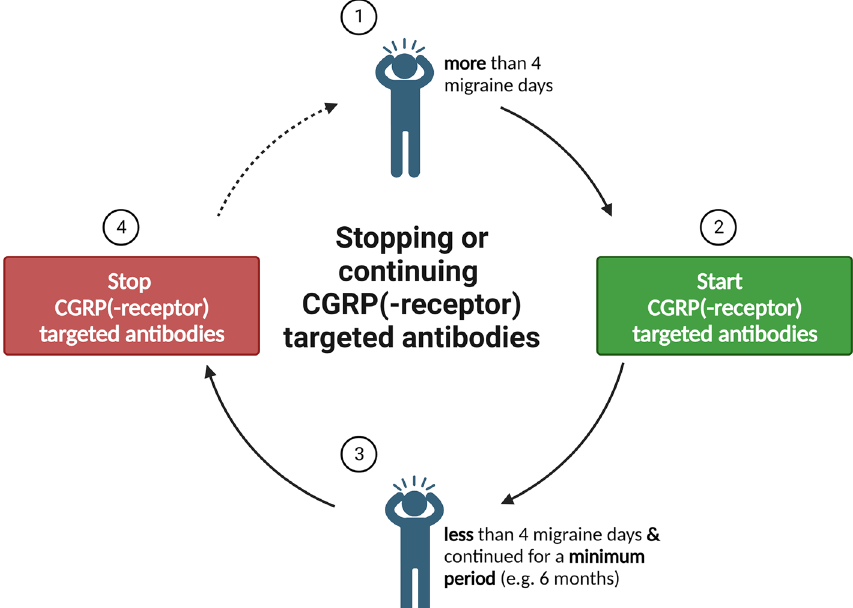
Fig. 1 An illustrative tool for stopping or continuing CGRP(‑receptor) targeted antibodies. Abbreviation: CGRP